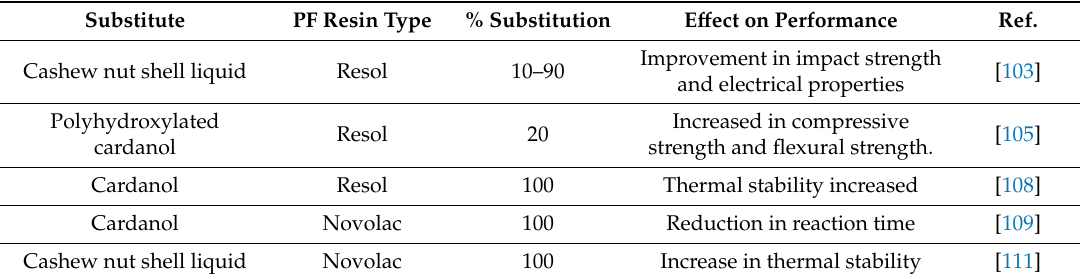
Table 3. Examples of cardanol substituted phenolic resin.